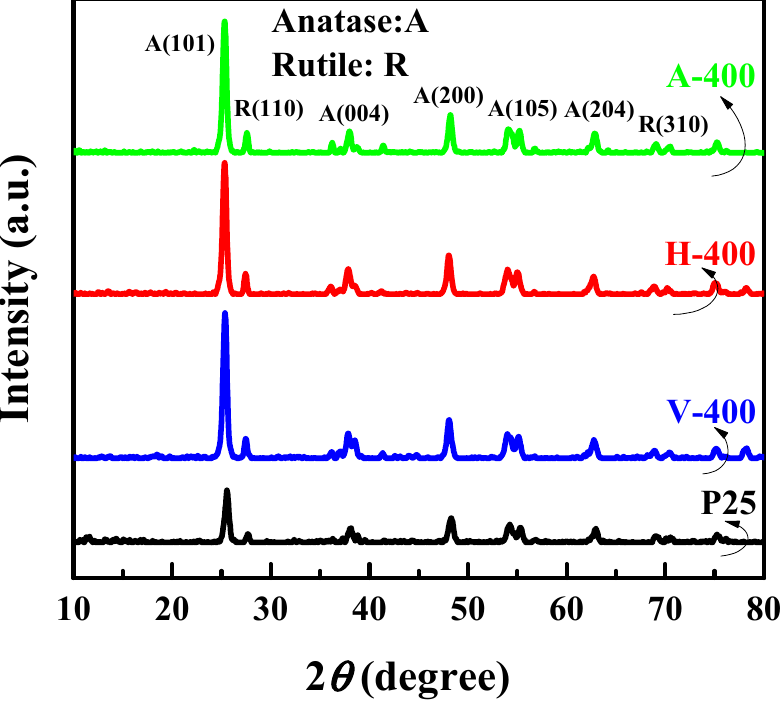
Figure 1. X-ray diffraction (XRD) pattern of P25, A-400, V-400 and H-400.